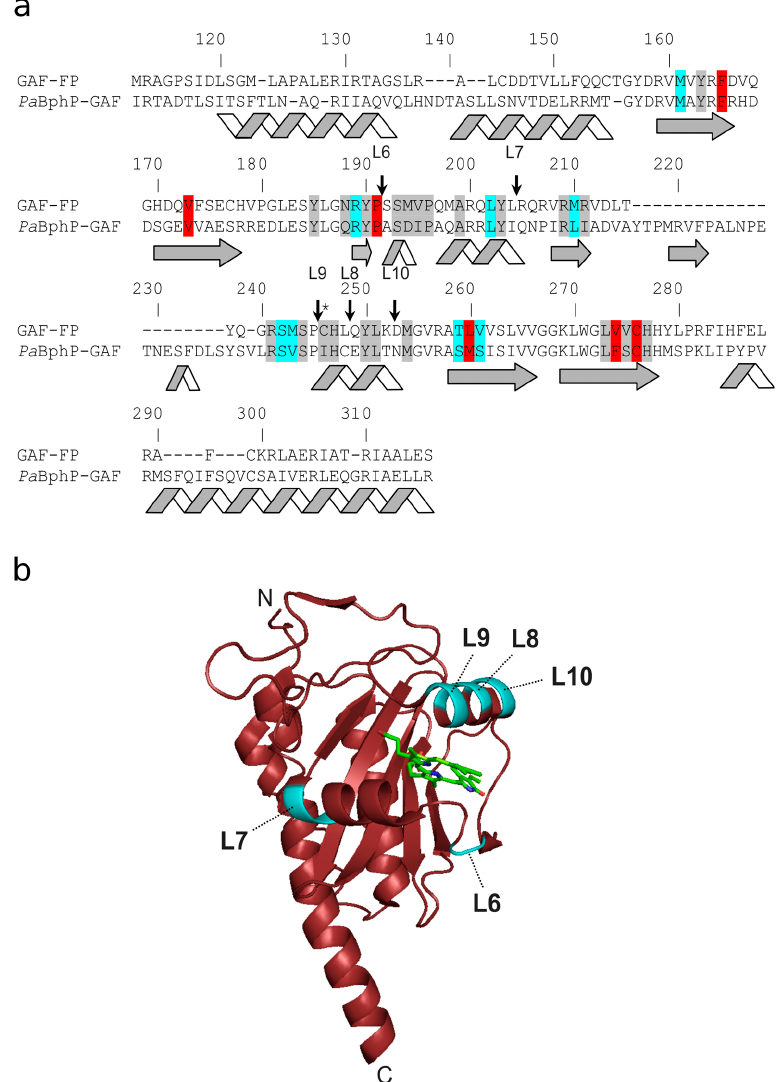
Figure 1. Alignment of the amino acid sequences of GAF-FP and GAF domain of Pa BphP ( Pa BphP-GAF) and representation of insertion sites of calcium binding domain. ( a ) Alignment numbering follows that of PaBphP. The residues which are within 4.5, 4.5 − 5.5, and 5.5 − 6.5 Å surrounding the biliverdin (BV) chromophore according to the X-ray structure of PaBphP (3C2W) are highlighted in grey, cyan, and red colors, respectively. Stars indicate Cys-residue that is covalently bound to the chromophore. Sites of insertion in the GAF-FP protein are indicated with arrows. ( b ) Insertion sites of calcium-binding domain are highlighted in cyan on X-ray structure of GAF domain (PDB 3C2W). The BV chromophore is shown in green.